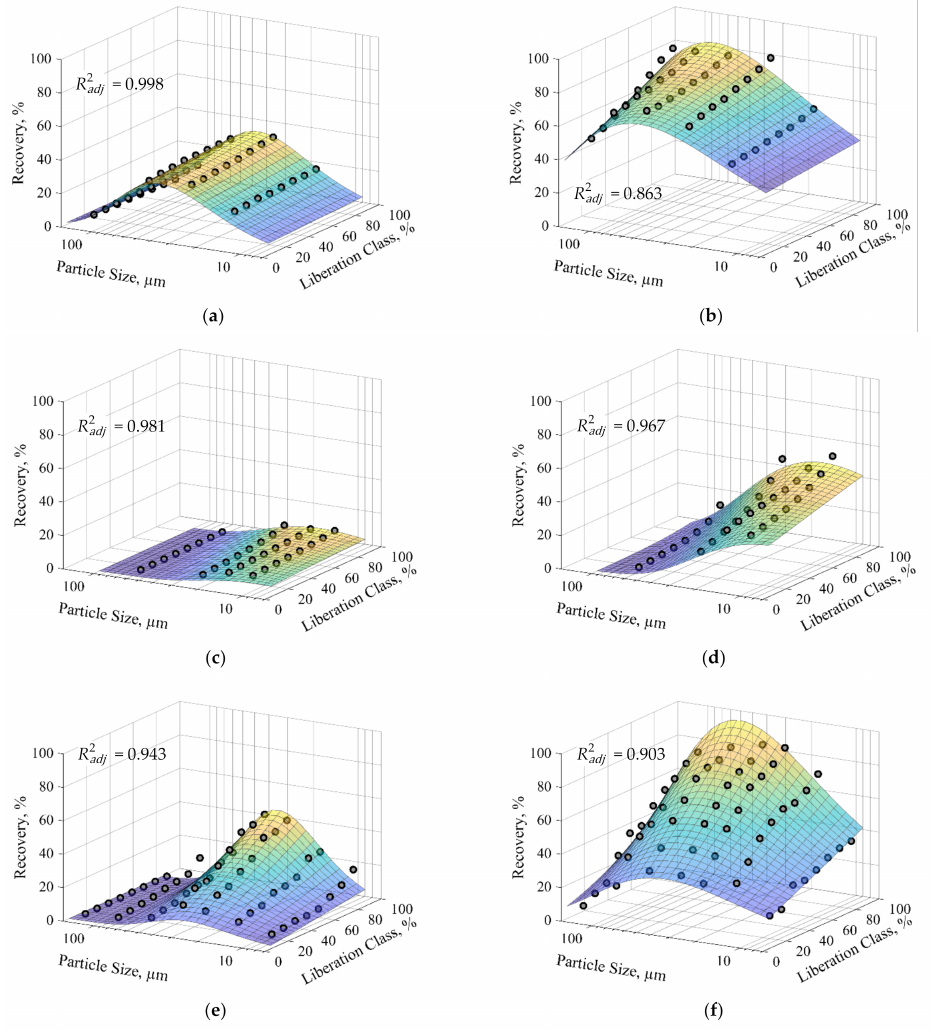
Figure 3. Size-by-liberation galena recoveries and model fitting: Vianna [8] ( a ) 5 g/ton of Aerophine 3418A, ( b ) 30 g/ton of Aerophine 3418A; Savassi [13] ( c ) 2 cells in series, ( d ) 12 cells in series; and Welsby [9] ( e ) 5 g/ton of Sodium Ethyl Xanthate, ( f ) 40 g/ton of Sodium Ethyl Xanthate. Experimental data are presented as datapoints and model fitting as 3D surfaces. Middling particles (10–90% liberation). Particle size axes are in